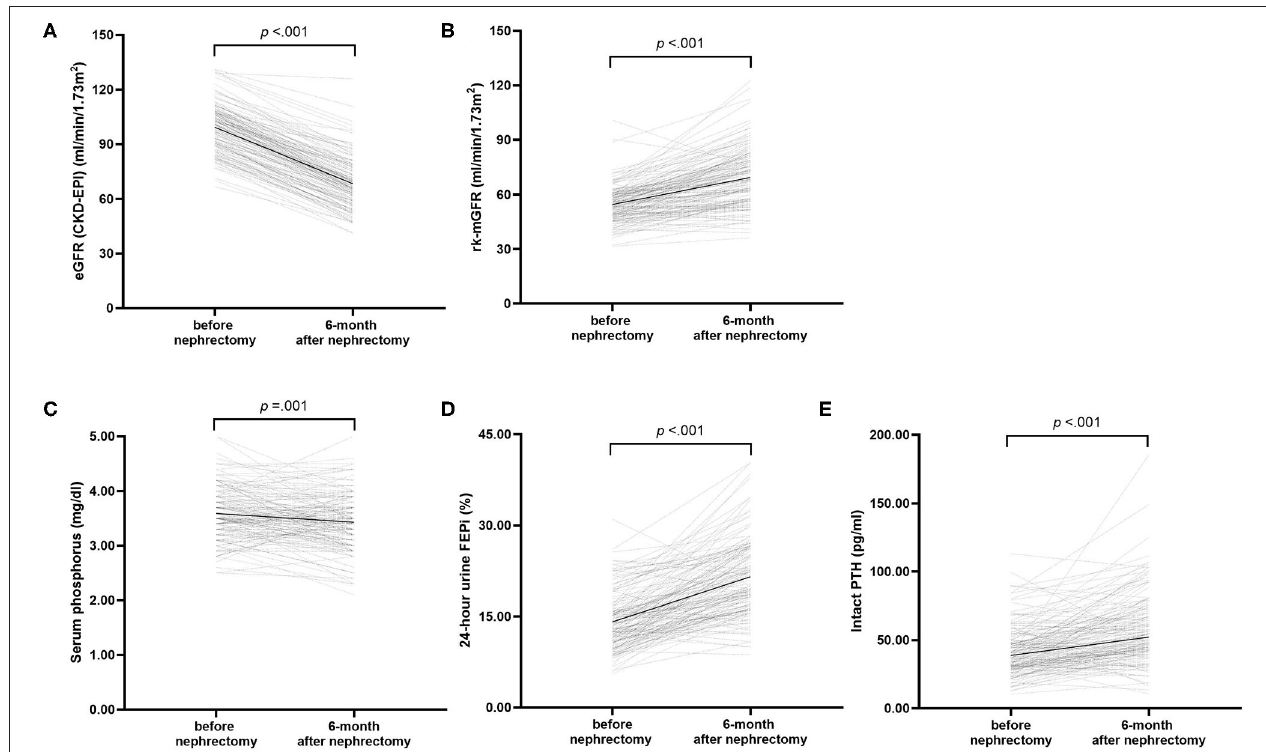
FIGURE 1 | Changes in renal function and the biochemical parameters after donation. (A) estimated glomerular filtration rate (GFR), (B) measured GFR of the remaining kidney, (C) serum phosphorus concentration, (D) 24h urine renal fractional excretion of phosphate, and (E) serum intact parathyroid hormone concentration. Black lines illustrated mean or median. p -values compare before after nephrectomy by paired t -test.